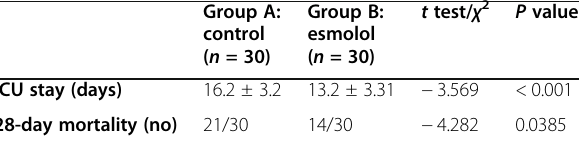
Table 9 Comparison between both groups according to ICU stay and 28-day mortality